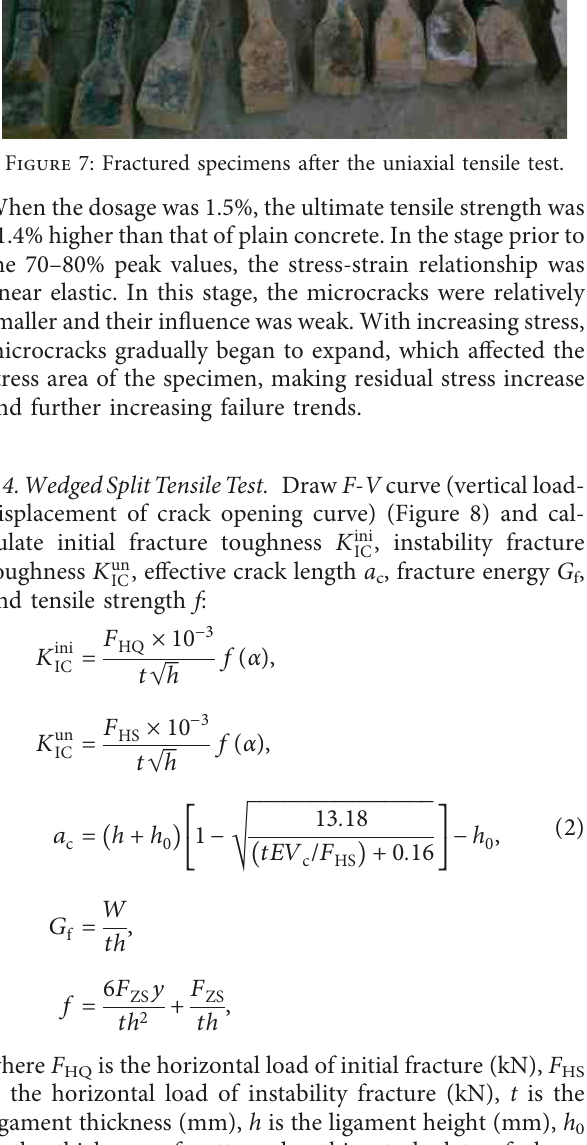
Table 4: Flexural strength test results.